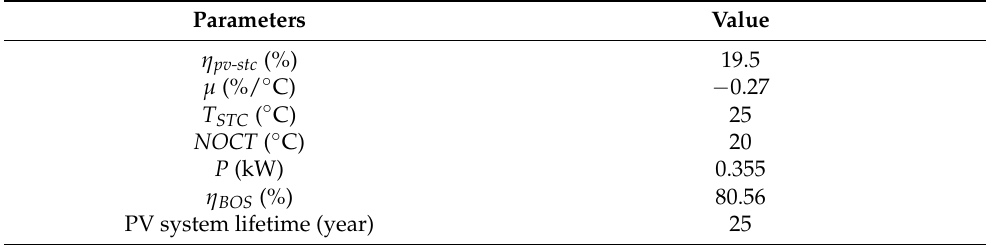
Table 1. Input Table 1. Input data.